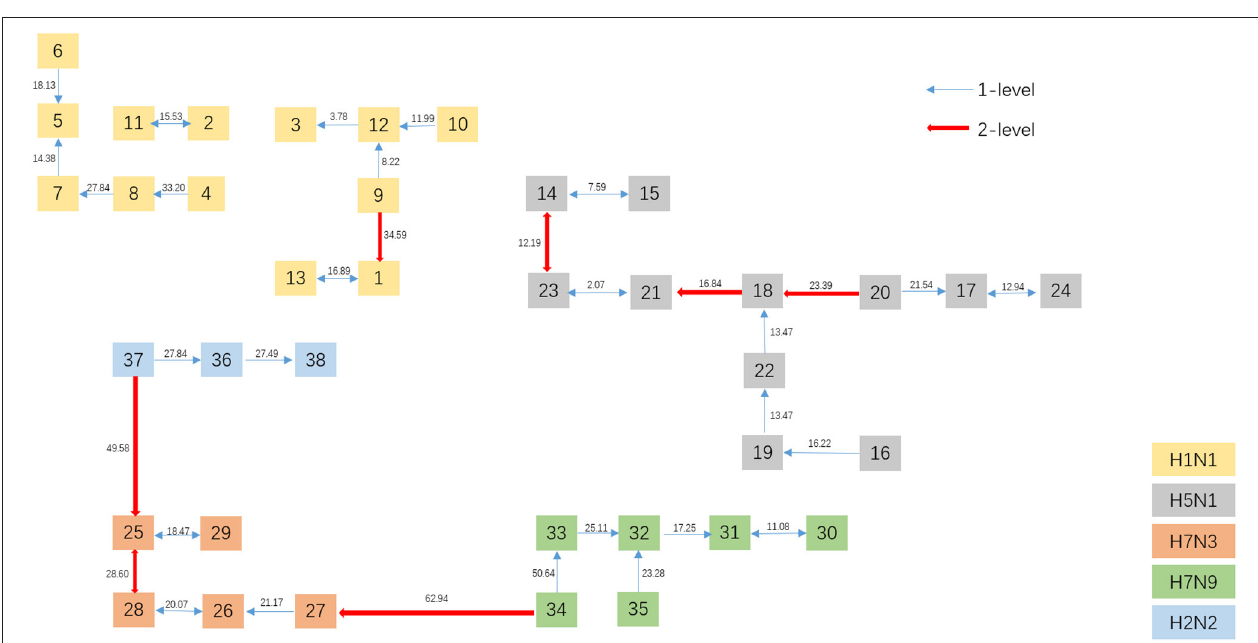
Guangdong Province (China) in 2015 and is an imported Middle East respiratory syndrome Coronavirus. The other one MERS- CoV/KOR is from South Korea (Kim et al., 2015). As of 15